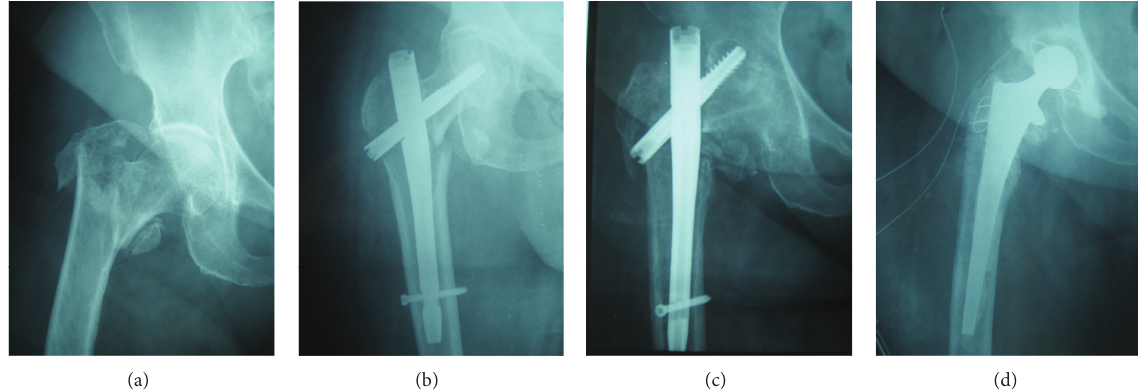
Figure 2: AP radiograph of an 81 yr patient with a 3-part intertrochanteric femoral fracture (a) treated with a short G3N (b). Cutout of the lag screw at 2 months postoperatively (c) treated with a THR